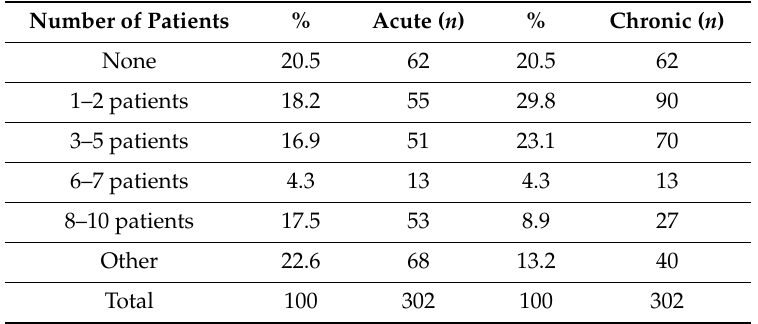
Table 1. Number of patients in whom physicians suspected opioid induced hyperalgesia (OIH) in an acute and chronic pain setting by physicians over their total career at the moment of survey ( n =